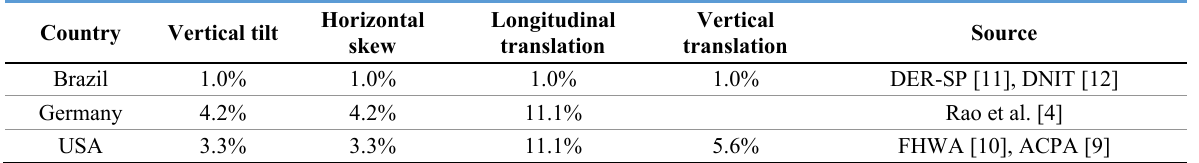
Table 1. Misalignment and misallocation tolerances.